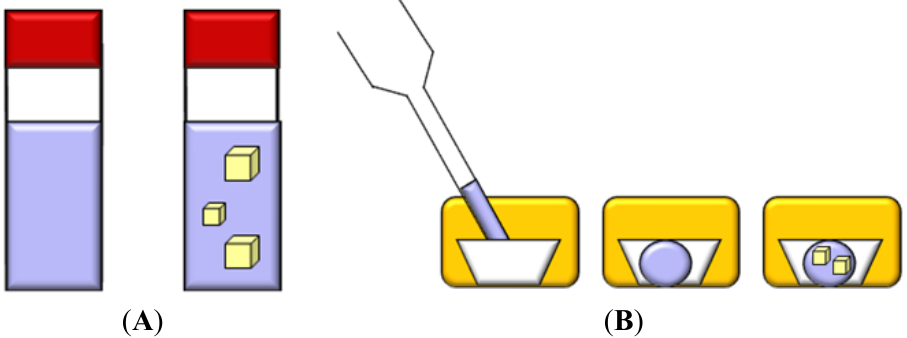
Figure 5. Batch and microbatch methods. ( A ) Batch method. Small vials containing pre-mixed protein and precipitant solutions at supersaturated conditions are sealed and left undisturbed; ( B ) Microbatch method. A small droplet containing both protein and precipitant at supersaturation conditions is immersed in an inert oil that prevents sample